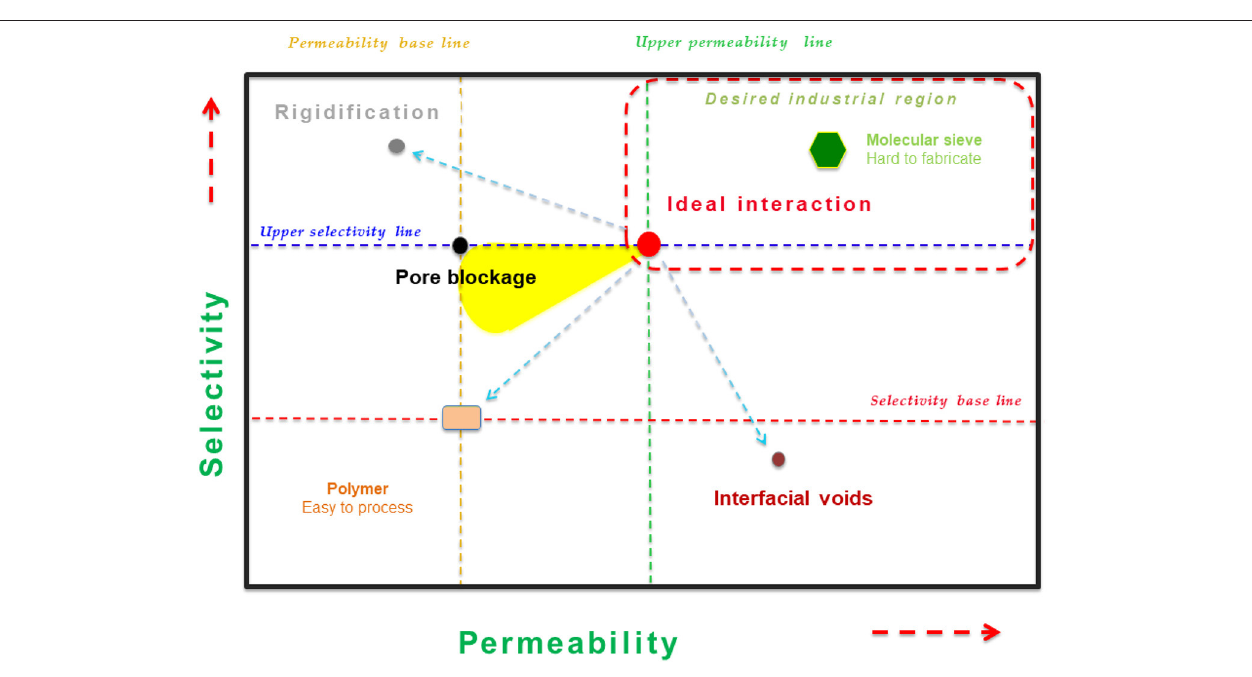
MOF synthesis (Castro-Muñoz and Fila, 2019). For this